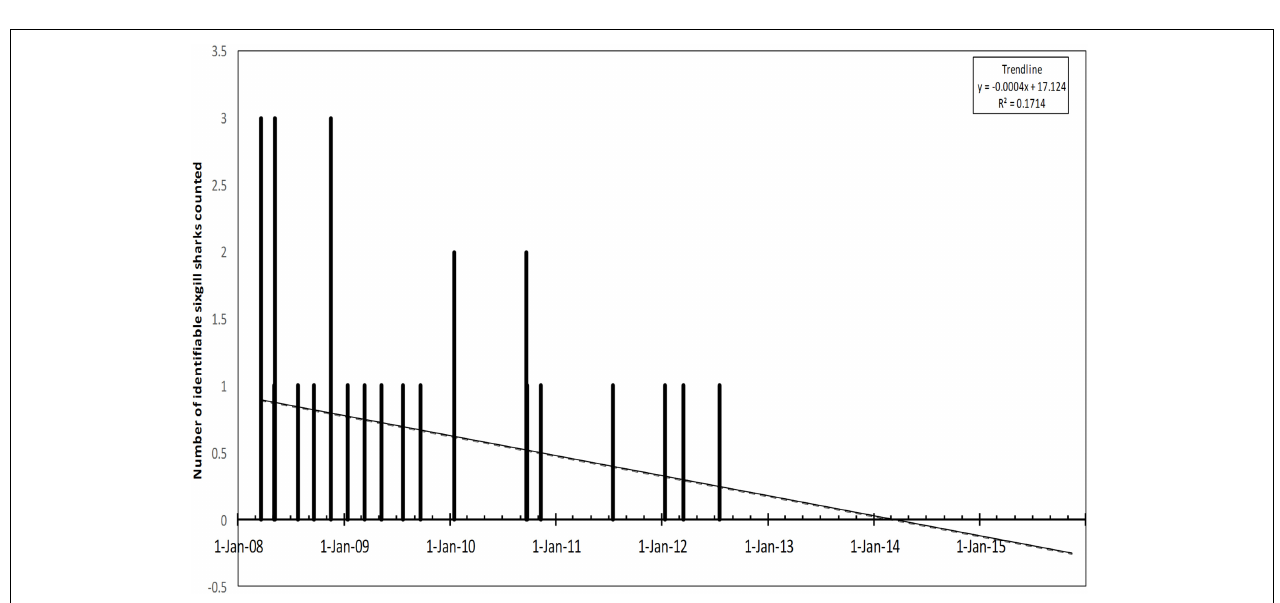
FIGURE 1 | Daily sightings during research events of Sixgill Sharks underneath the Seattle Aquarium between 2003–2005 and 2008–2015.